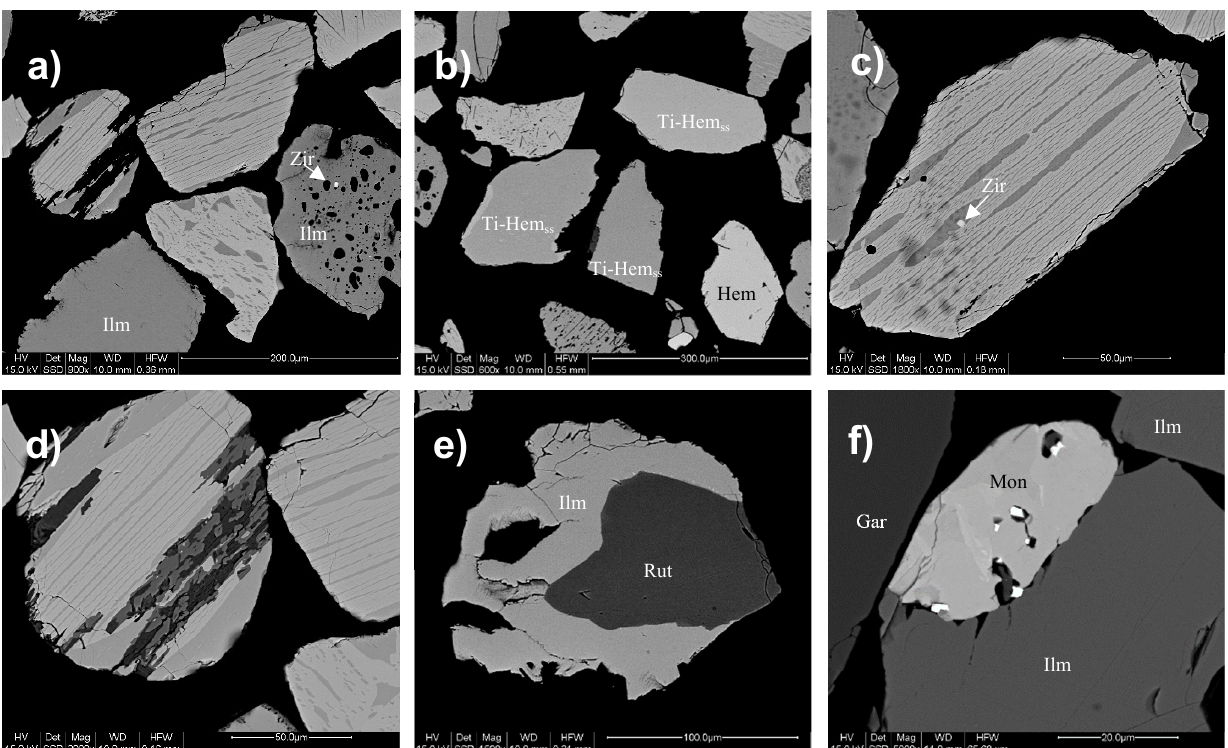
Figure 6. Back-scattered electron (BSE) images of the bulk ilmenite sample showing textures of the various Fe-Ti oxide particles as well as images showing grains with inclusions of potentially valuable heavy minerals. ( a – c ) show typical ilmenite textures with grains showing examples of titanohematite (Ti-Hem ss ) exsolution (banded grains), homogeneous ilmenite grains (also in ( e , f )) as well as homogeneous hematite grains ( c ). The presence of primary, unaltered inclusions (e.g. quartz in the highly porous-looking ilmenite towards the top left of ( a )) and sphene (titanite) and garnet incorporation in the exsolved ilmenite shown in ( d ). Inclusions of other valuable minerals typically associated with heavy mineral Fe-Ti-oxides such as rutile ( e ), zircon (small, bright spots in ( a , c ) and monazite ( f ) were also noted. Key to abbreviations used: Ilm = ilmenite; Ti-Hem ss —solid solution between titanohematite and hematite; Hem = hematite, Rut = rutile, Gar = garnet, Zir = zircon and Mon = monazite. Note that the small very high contrast grains associated with monazite in ( f ) represent ThO 2 grains.